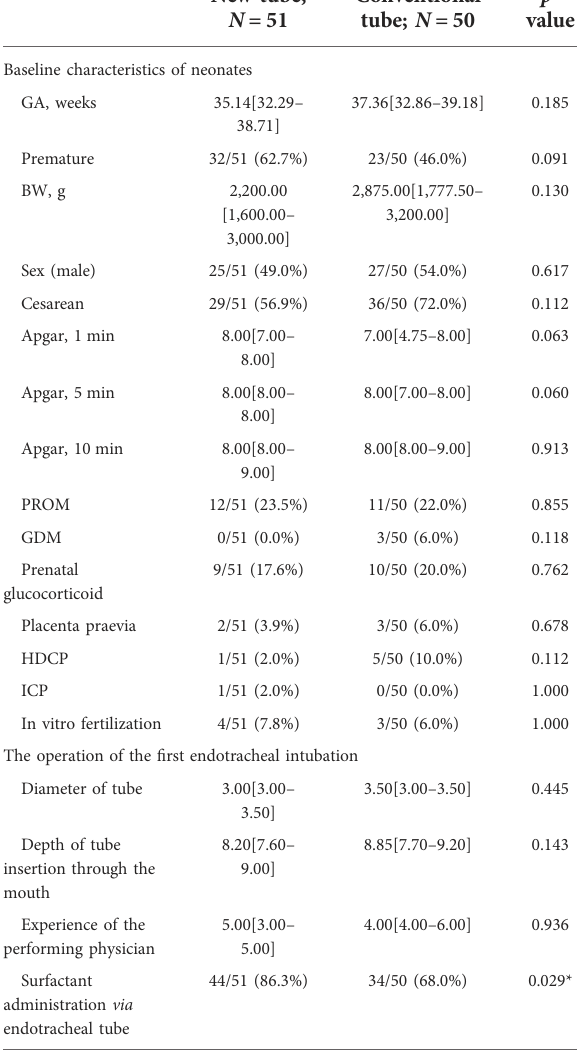
TABLE 2 Basic information on neonates with new or conventional tracheal